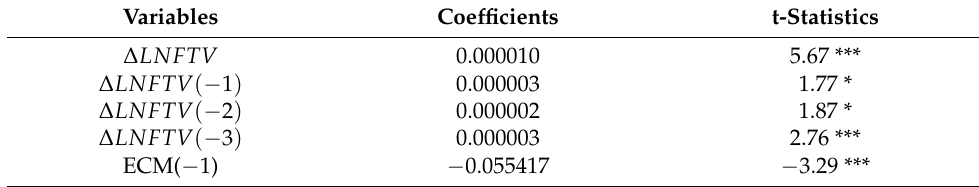
Table 5. The estimated short-run coefficients.